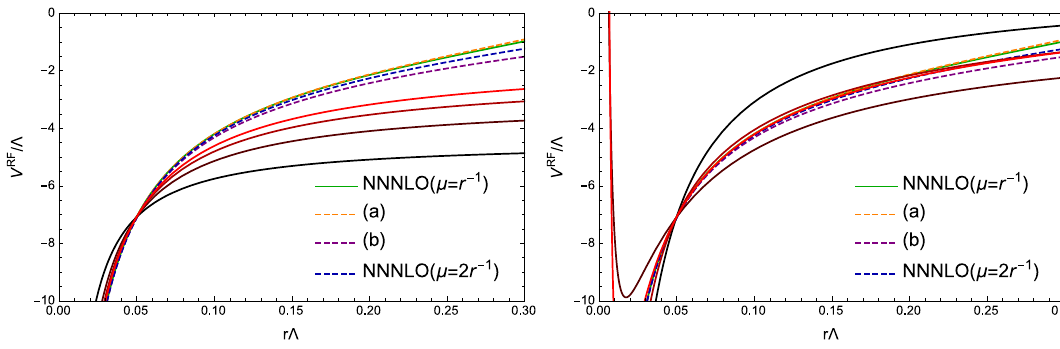
Figure 15 . V RF = (cid:3) (green), its error, and (cid:12)xed order results. The orange dashed line corresponds MS to prediction (a) [NNLO form of the ambiguity function and NNNLO perturbative series] and the purple one to prediction (b) [NNNLO form of the ambiguity function and NNLO perturbative series]. We also show the prediction with the renormalization scale at (cid:22) = 2 r (cid:0) 1 by the blue dashed line. We compare them with (cid:12)xed-order results, where the black line corresponds to the LO result and deeper red line corresponds to higher order result. In the left panel, we take the renormalization scale as (cid:3) =(cid:22) = 0 : 0026 such that (cid:11) s ( (cid:22) ) = 0 : 1, and in the right panel, we take it as (cid:3) MS such that (cid:11) s ( (cid:22) ) = 0 : 3. The heights of the potentials of the (cid:12)xed-order results and the central value of V RF = (cid:3) are adjusted at r (cid:3) = 0 : MS MS